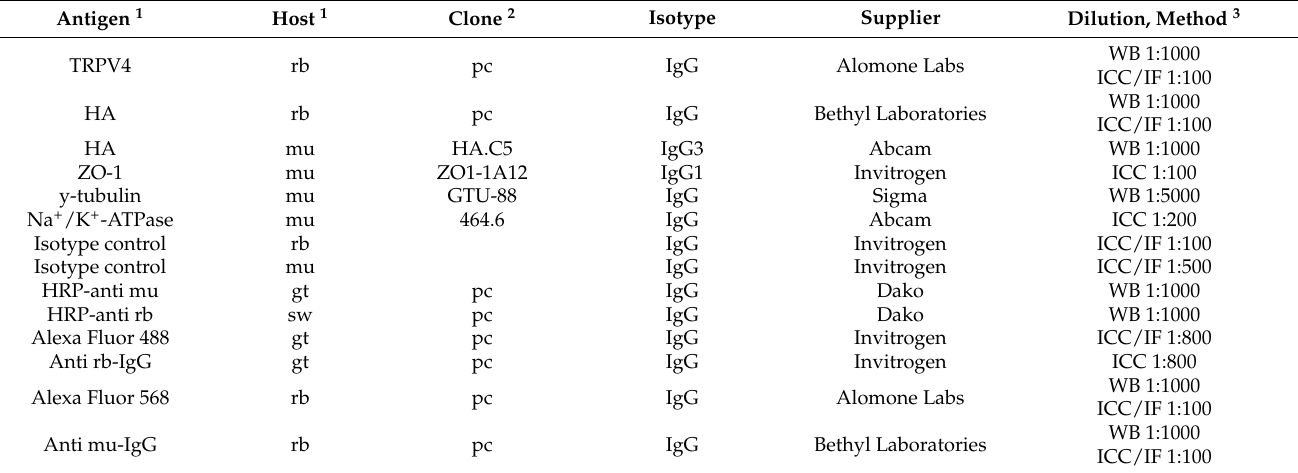
Table 1. Primary and secondary